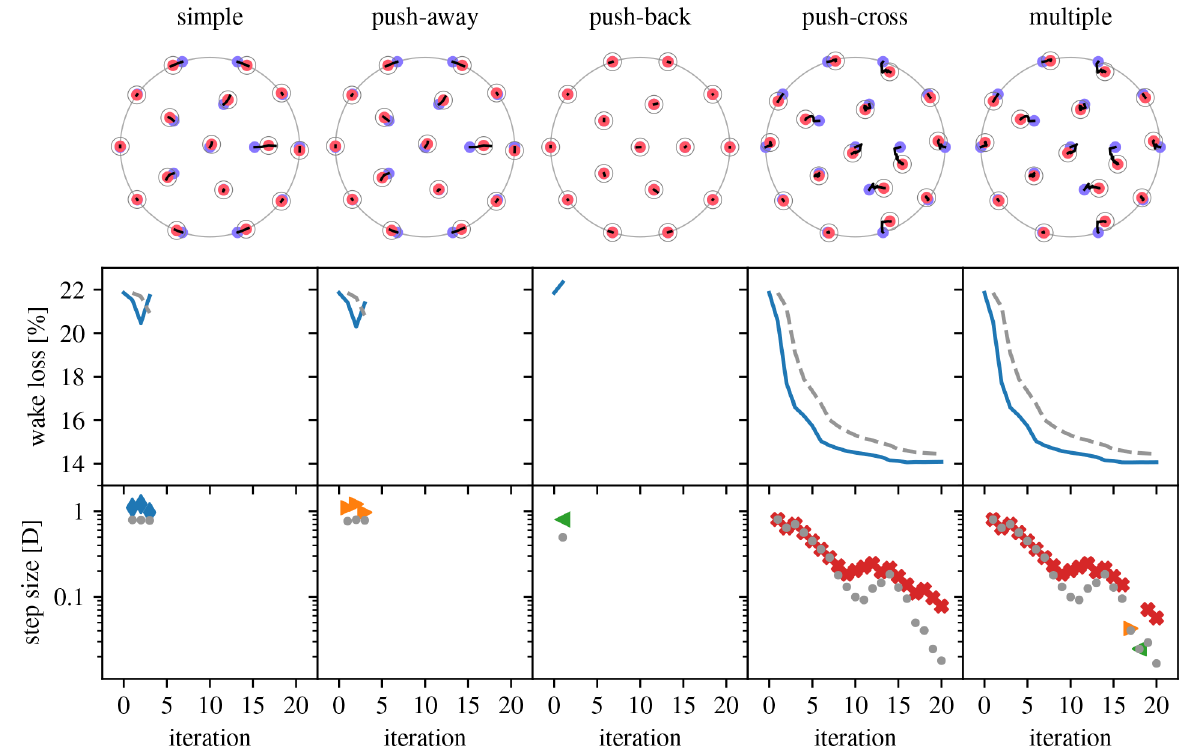
Figure 11. Overview of optimization runs for the IEA Wind Task 37 Case Study 1 16-turbine site using the different types of pseudo- gradients. (Legend in Table 1.)